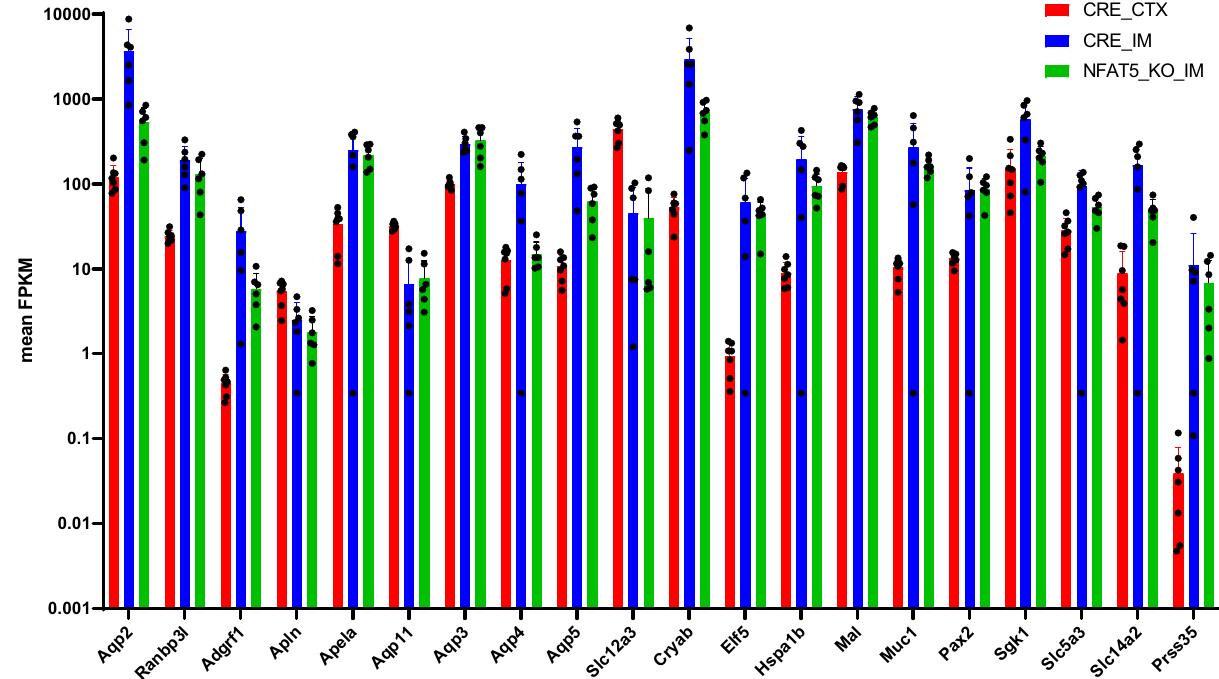
Figure 4. Expression level of selected osmo-regulated genes in cortex and inner medulla. Expression level (mean FPKM) of selected genes that are differentially expressed between the cortex (CTX) and inner medulla (IM) of control (CRE) kidneys. The green bars show the expression level of these transcripts in the IM of principal cell specific NFAT5 deficient mice